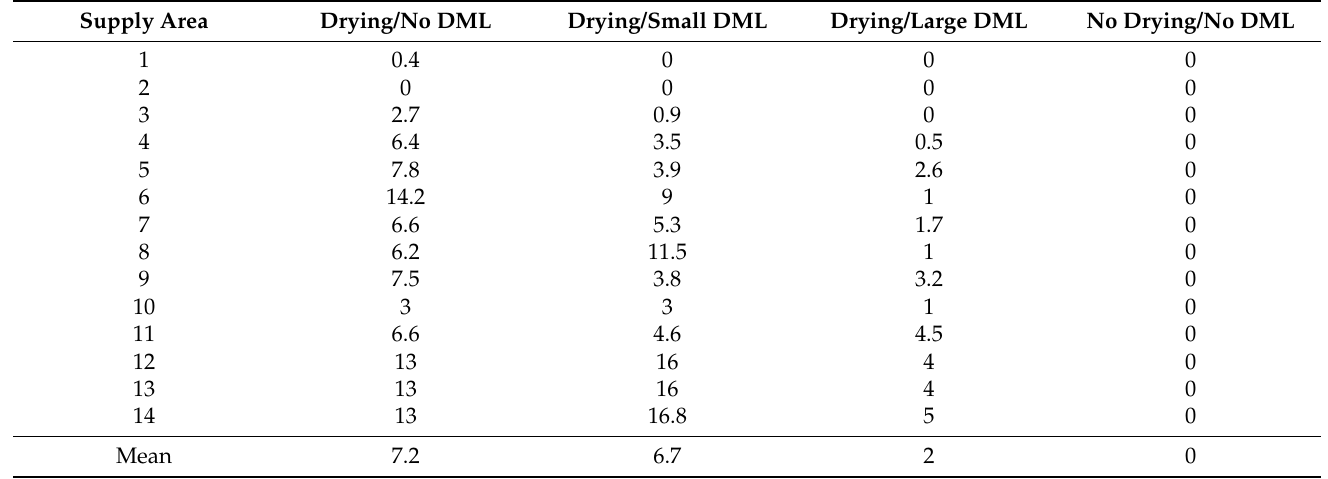
Table 5. Drying time (in months) of roundwood and biomass by scenario and supply